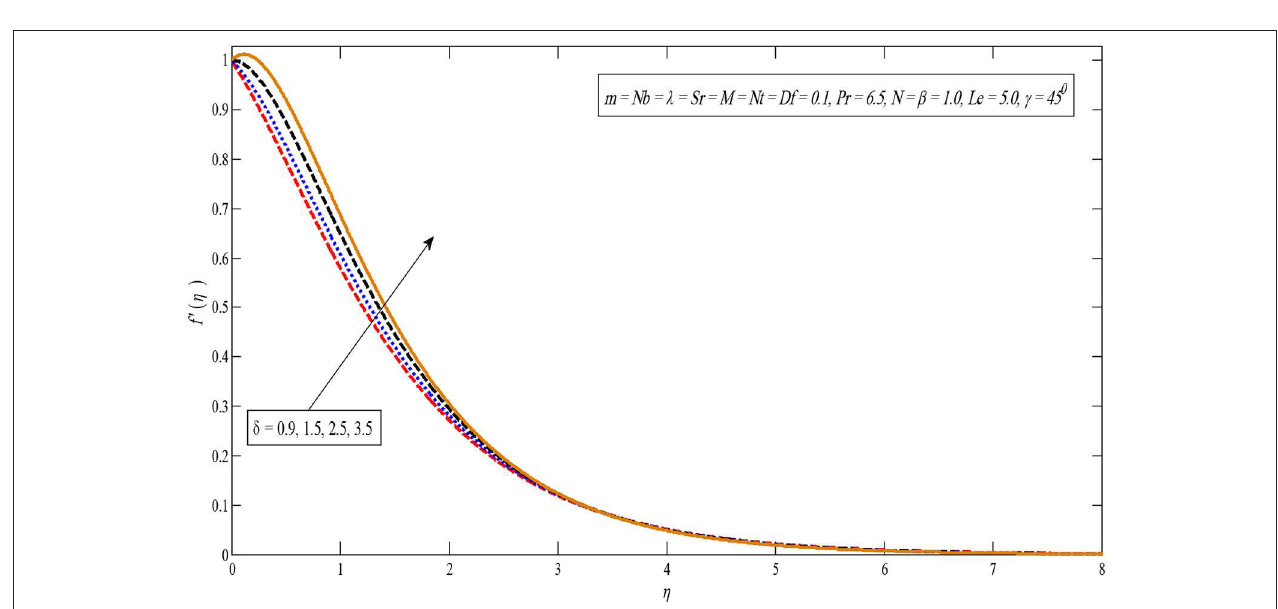
FIGURE 5 | Velocity profile for several values of δ